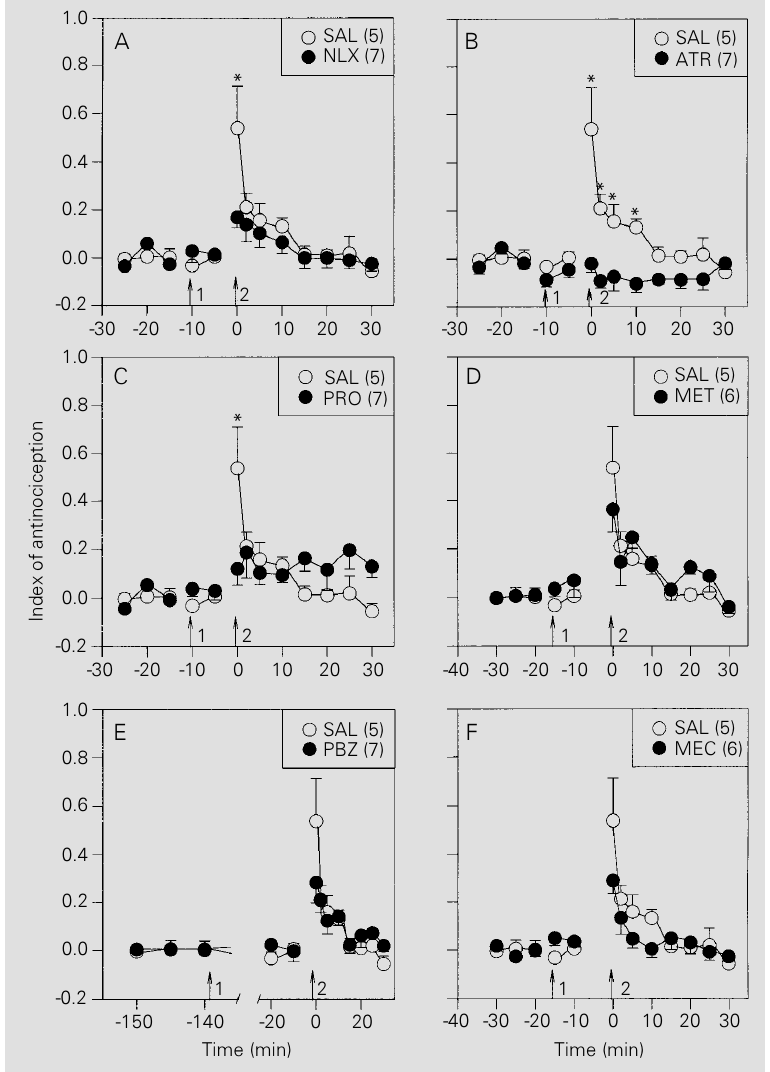
Figure 3 - Effects of intraperitoneal administration (arrow 1) of saline (SAL; 0.1 ml/kg) or antagonists (1 mg/kg) on the antinociception induced by electrical stimulation (arrow 2) of the central nucleus of the amygdala of rats. A , Effect of naloxone (NLX); B , effect of atropine (ATR); C , effect of propranolol (PRO); D , effect of methysergide (MET); E , effect of phenoxybenzamine (PBZ); F , effect of mecamylamine (MEC). The number of rats per curve is given in parentheses. Data are reported as means – SEM for each group of rats. *P<0.05 compared to drug-treated animals (Duncan